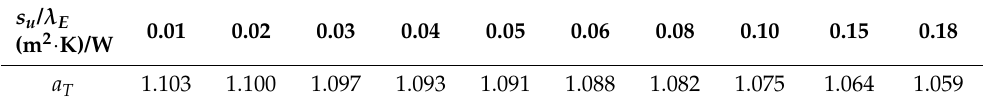
Table 1. Pipe spacing coefficient a T versus pipe spacing L for type B systems, [25–29]. s u / λ E (m 2 ·